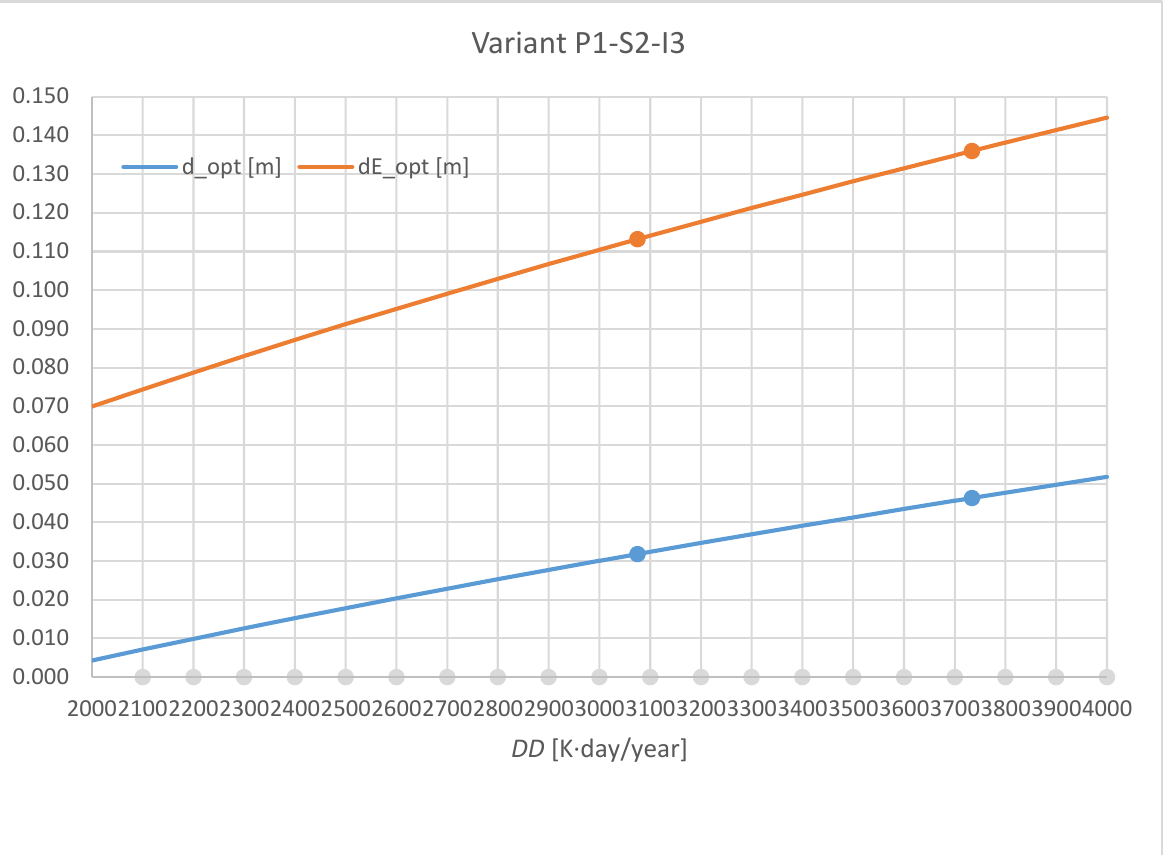
Figure 2. Optimal thermal insulation thickness d opt and d Eopt depending on the degree days DD for the P1-S2-I3 variant.